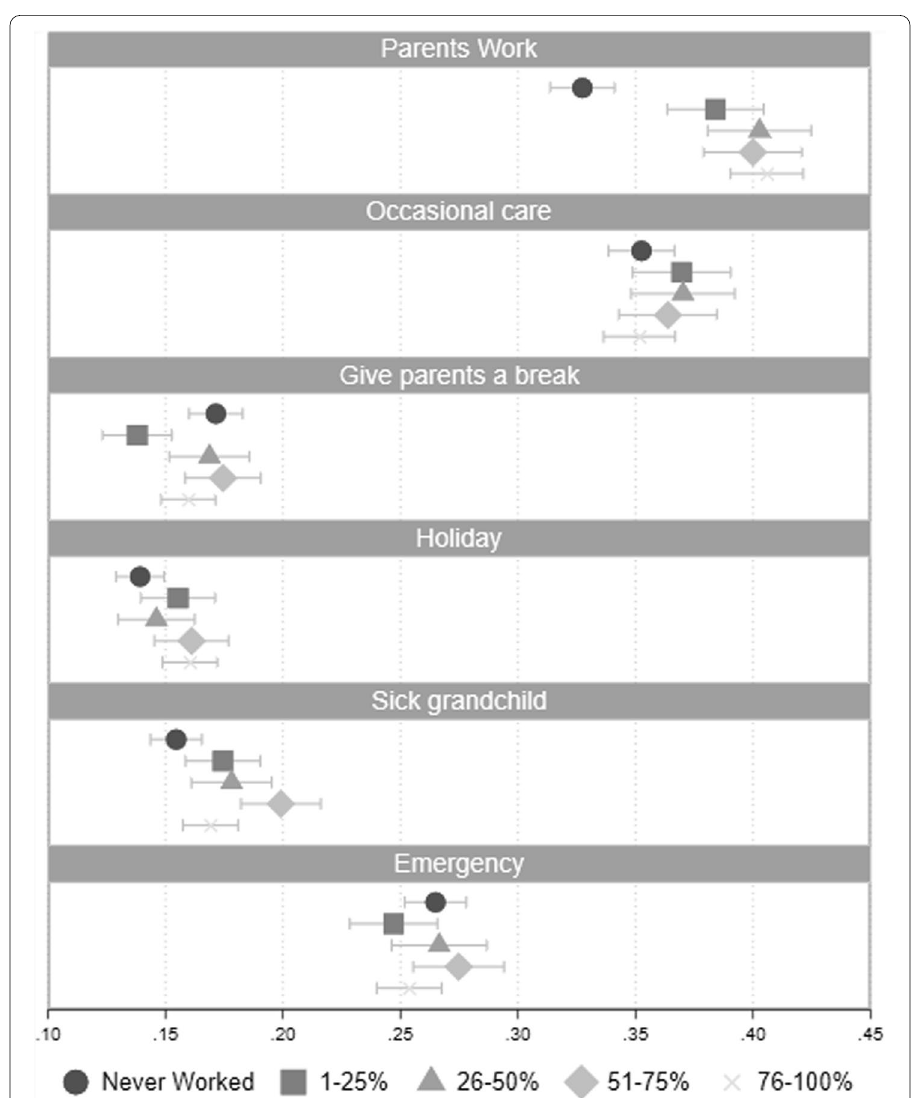
Fig. 4 Predicted probabilities ( x -axis) to perform grandparental childcare under different circumstances, by grandmothers’ work history: percentage of adult life (18–49) worked. Results from logistic regression models, control variables included: age; occupational status; birth cohort; educational level; area of residence. CI for approximate 5% significance level for the comparison of pairs of predicted probabilities. Source : Authors’ elaborations on Multipurpose surveys on Families and Social Subjects—ISTAT, 2003, 2009, 2016. N